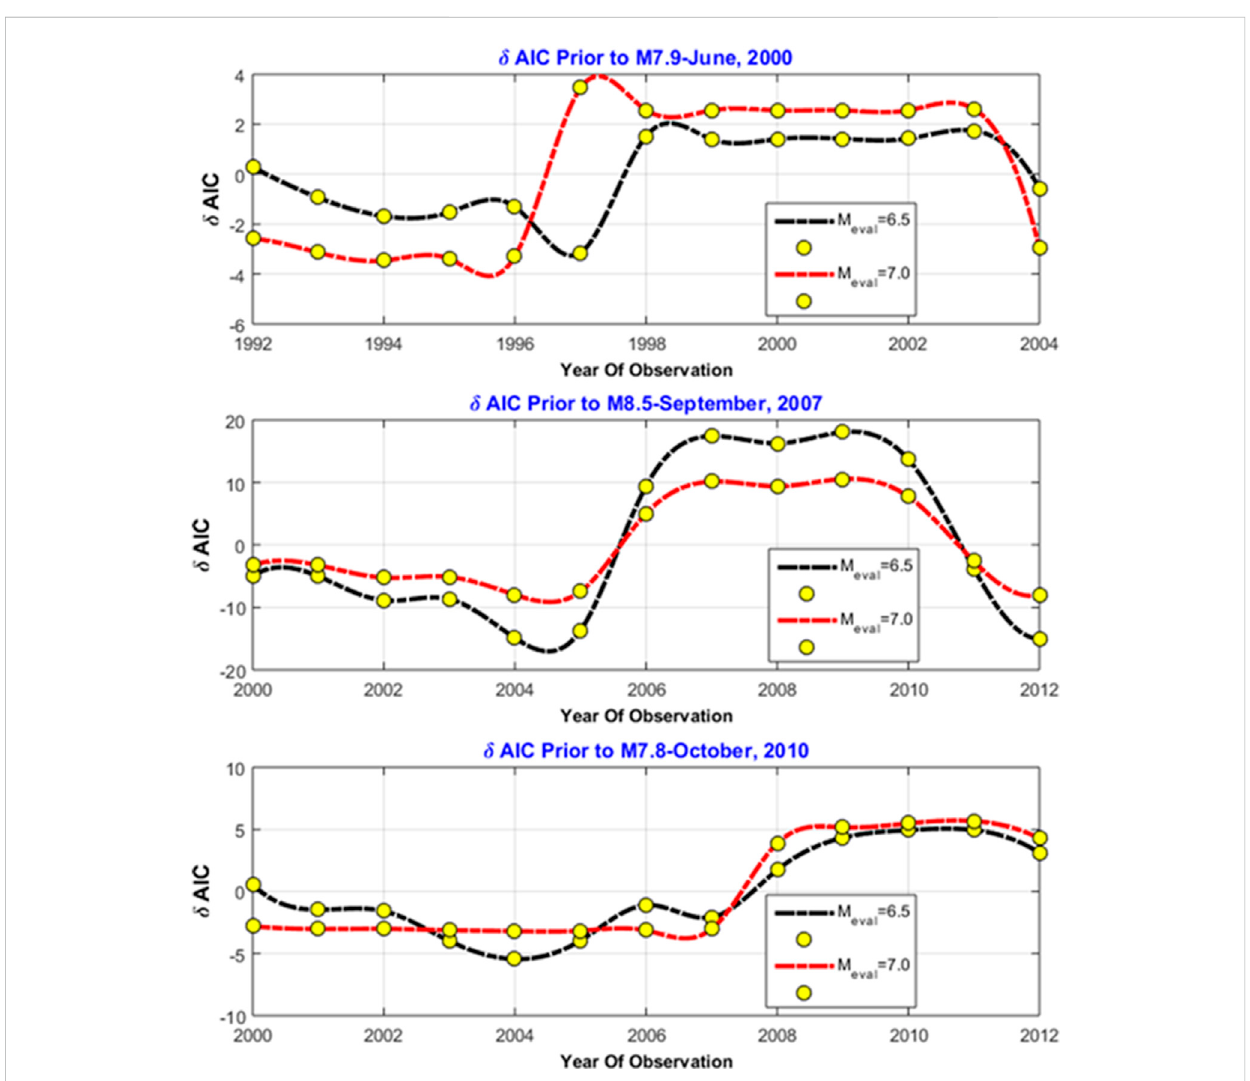
Plot of the time of observation versus δ AIC with M ref of 6.5 and 7.0. The δ AIC was calculated before the large earthquake of M7.9 in 2000, M8.5 in 2007, and M7.8 in 2010. The result shows a signi fi cant positive gradient before the large earthquake event. It consistently happened for the three events that were